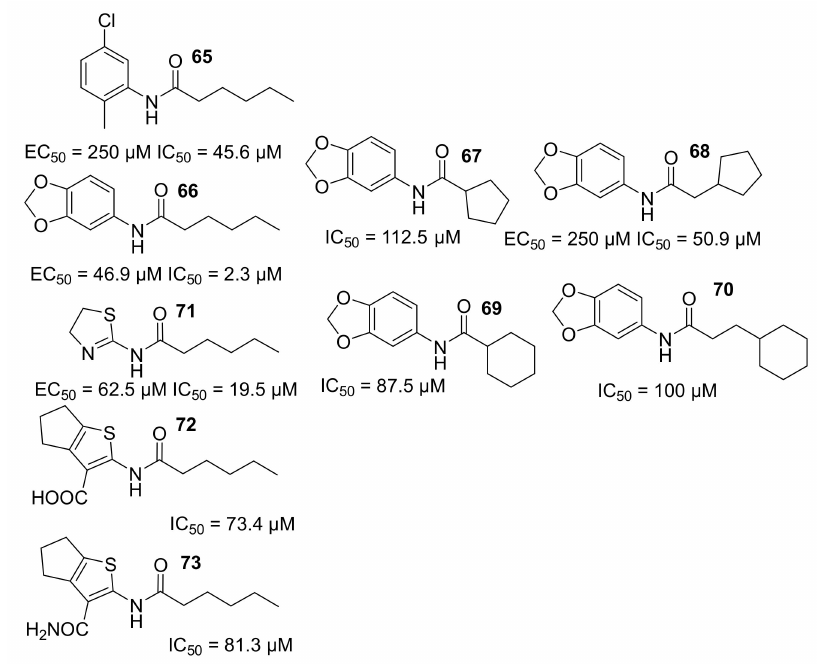
Figure 9. Structure of carboxamide derivatives as CviR modulators.